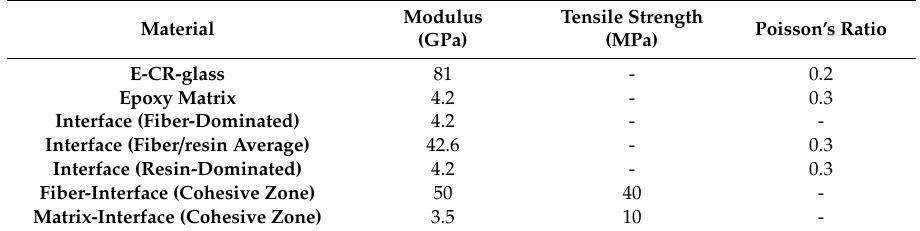
Table 3. Input properties for three-phase model where interface is modeled as a separate entity.